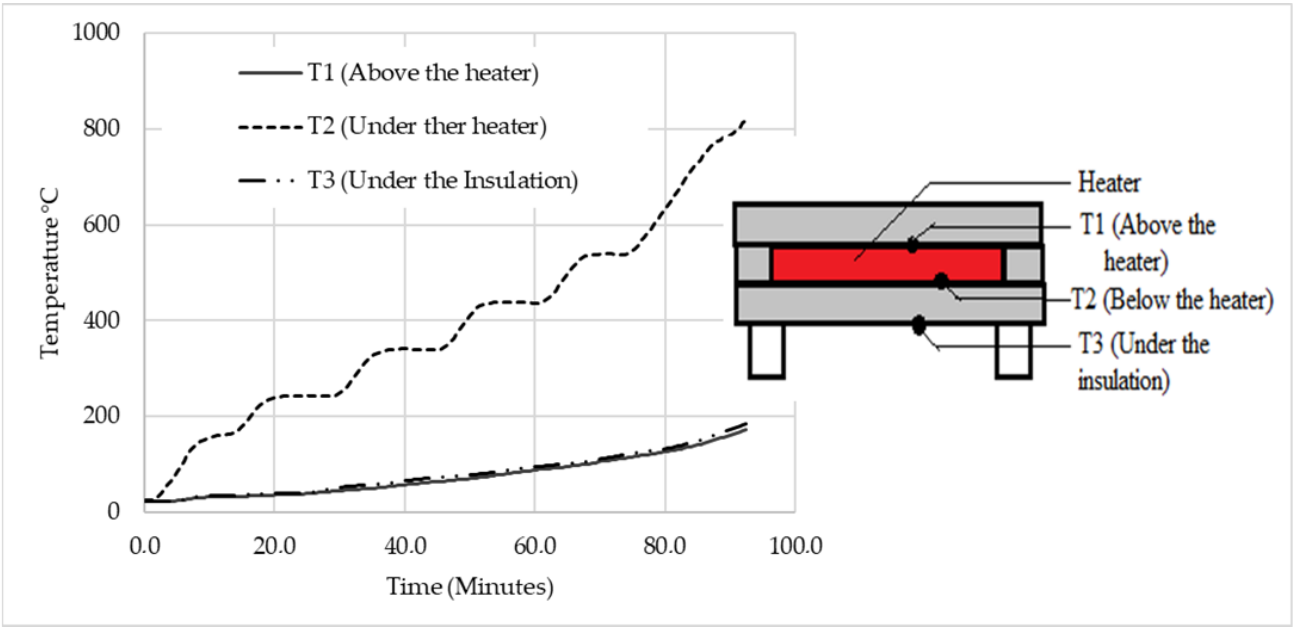
Figure 6. Heater thermal efficiency experimental results.